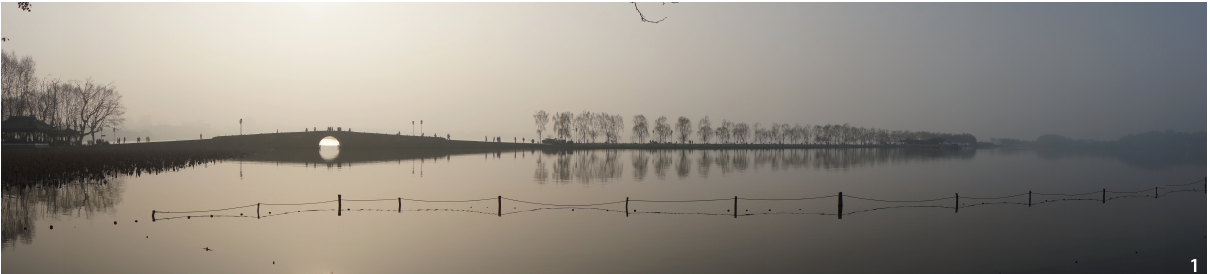
Figure 1 The West Lake in Hangzhou: The Heaven on Earth (Source: the author).